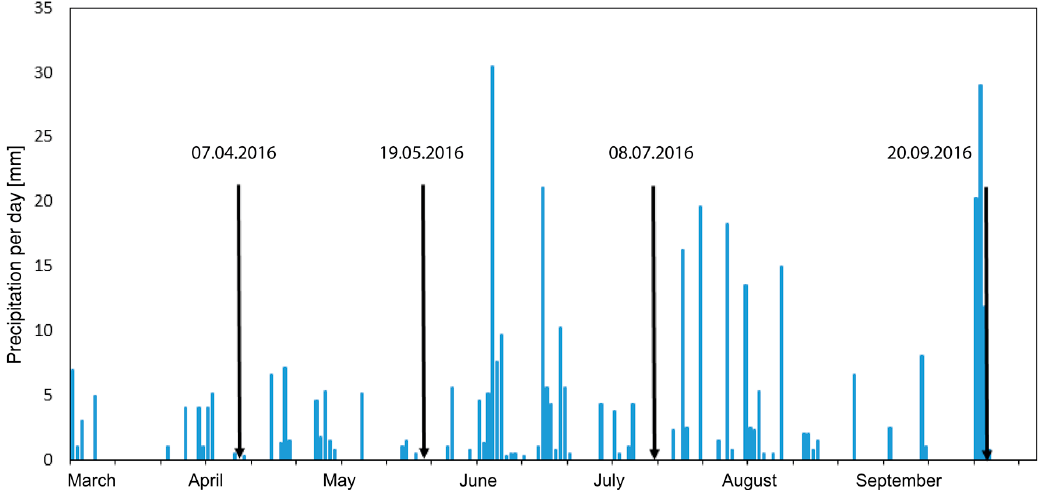
Figure 13. Precipitation records from the Czech meteorological service over the course of the study. Data from recording station Cheb. The black arrows specify to the dates of the field campaigns.